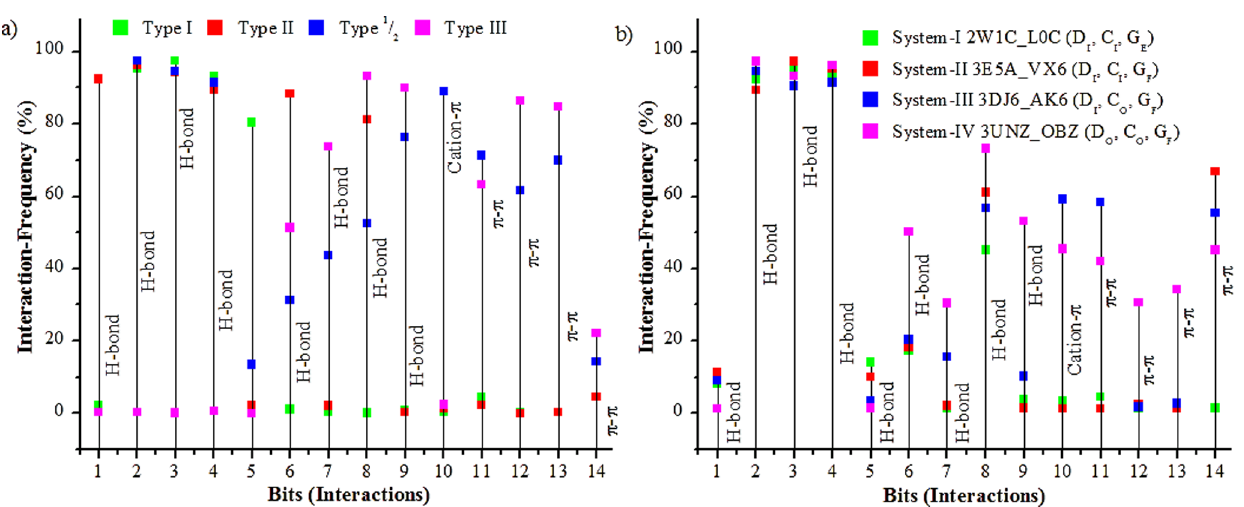
Figure 4. Major interaction sites in AK. The graphs depict the frequency of the most prominent interactions with different regions of the binding site formed by a) different classes of AK inhibitors from PDB and b) by the inhibitors bound to the four representative conformations during the 40 ns MD simulation. The four classes of inhibitors depicted in fig. 4a are the type I inhibitors which bind to the conserved ATP site in the DFG-in conformation, the type I 1 / 2 which explore an additional back-pocket (BP) formed by the GK in addition to the ATP site in the DFG-in conformation, type III which bind to the allosteric pocket (HPII) in the DFG-out conformation and the type II which explore both the ATP and allosteric pockets in the DFG-out conformation. The details of the simulated systems and inhibitors in fig. 4b have been given in Table 1. The legend 4b describes the system, PDB id of the starting structure, its bound inhibitor and conformation of the major structural motifs. The x-axis represents interactions formed by different pharmacophore and their complementary sites in the binding pockets as given in Table